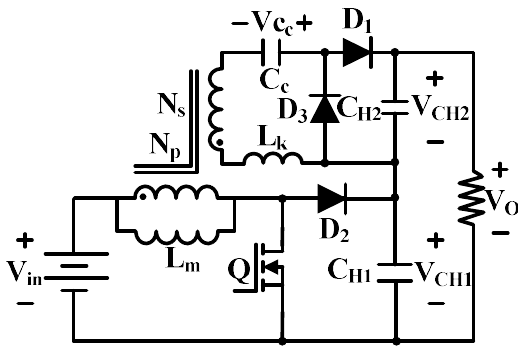
Figure 18. High conversion ratio boost converter.